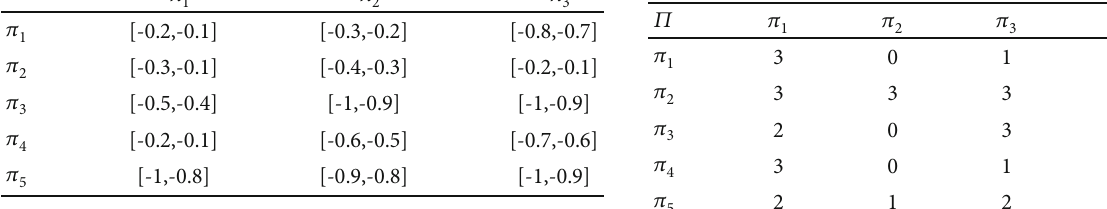
Table 16: The comparison table of Table 13.